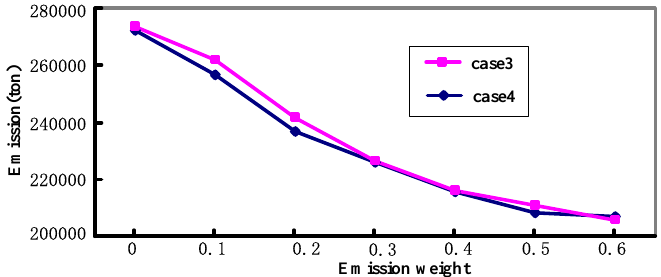
Figure 7. The influence of PHEVs on emission in smart grid.